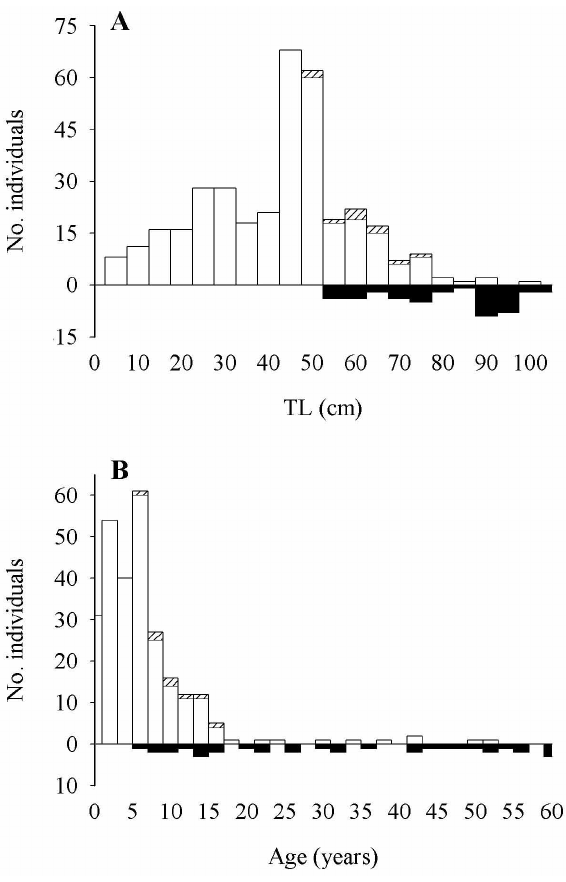
Fig . 2. – Length (A) and age (B) frequency distributions for females (white bars), transitionals (striped bars) and males (black bars) of Epinephelus marginatus . Data grouped by 5 cm TL and 2 years.